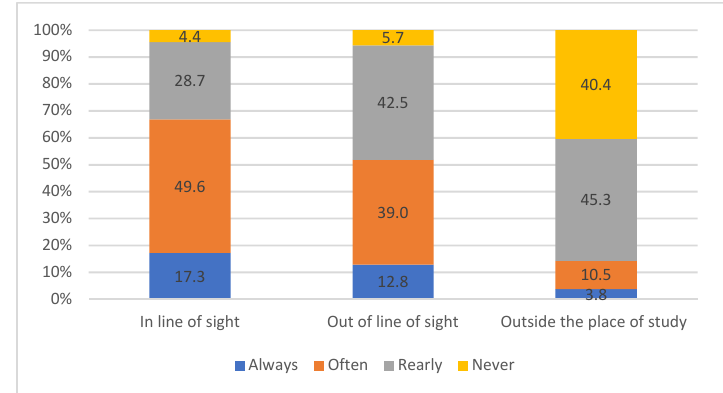
Figure 9. Phone range at work.